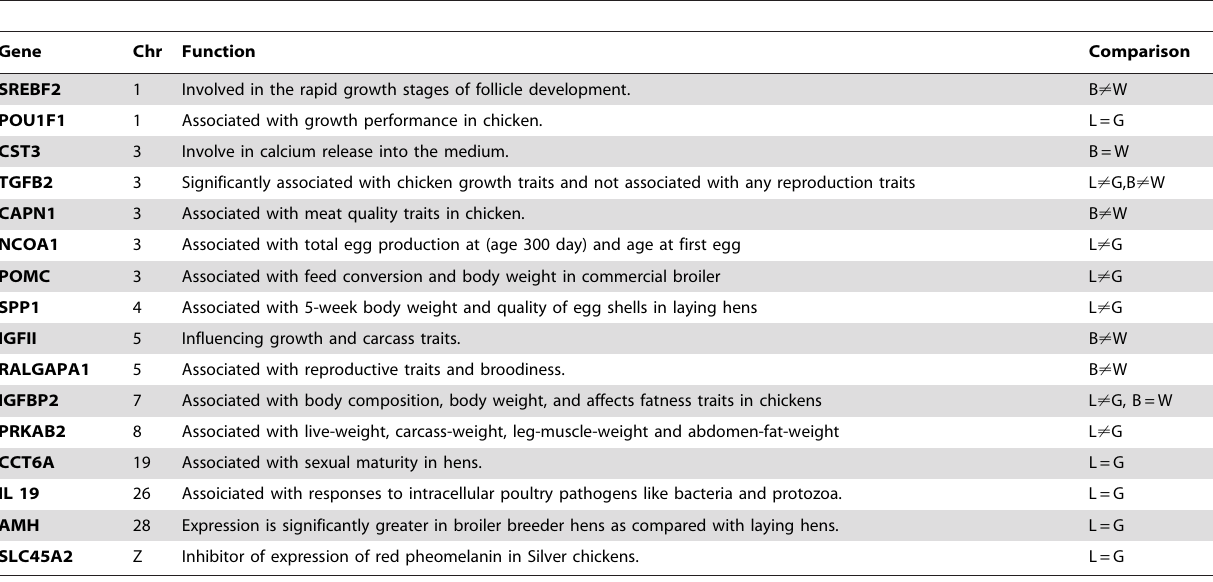
Table 4. Genes associated to productive traits in both comparisons. ? symbol stands for difference between two group and = symbol stand for similarity between two